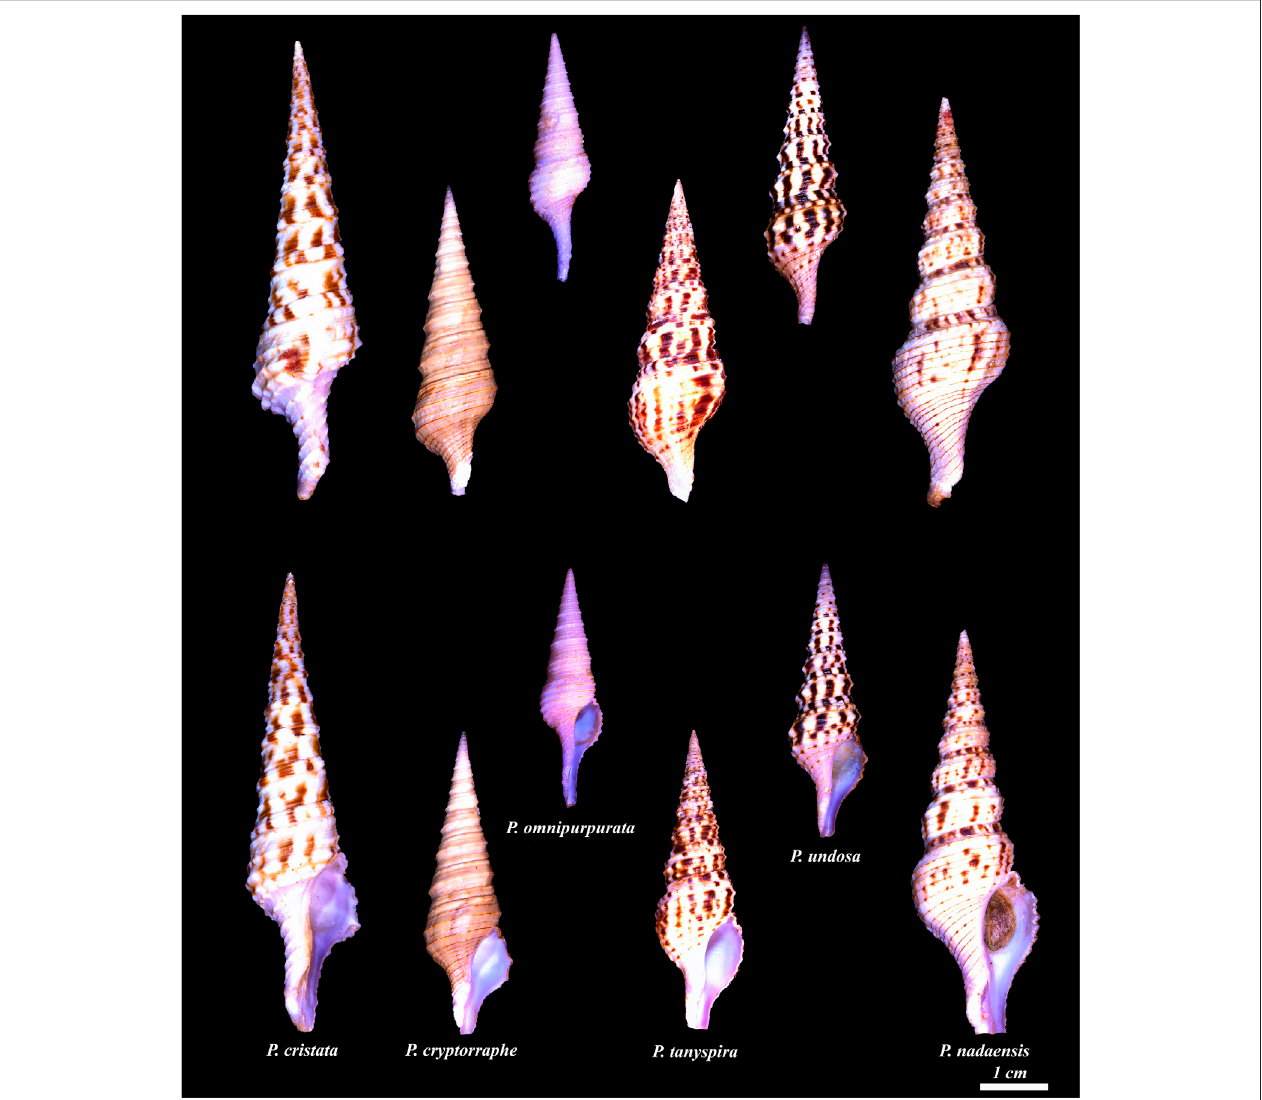
Appendix Figure 1 | Species in Purpuraturris gen. nov. from left to right: Purpuraturris cristata ; Purpuraturris cryptorraphe, type species; Purpuraturris omnipurpurata ; Purpuraturris tanyspira ; Purpuraturris undosa ; Purpuraturris nadaensis . Top row shows dorsal view, bottom row shows the apertural view. The shells were photographed individually and the photographs were cropped to maintain the size of the shells relative to each other. The scale bar represents an approximate length of 1 cm. (Photographed by Samuel